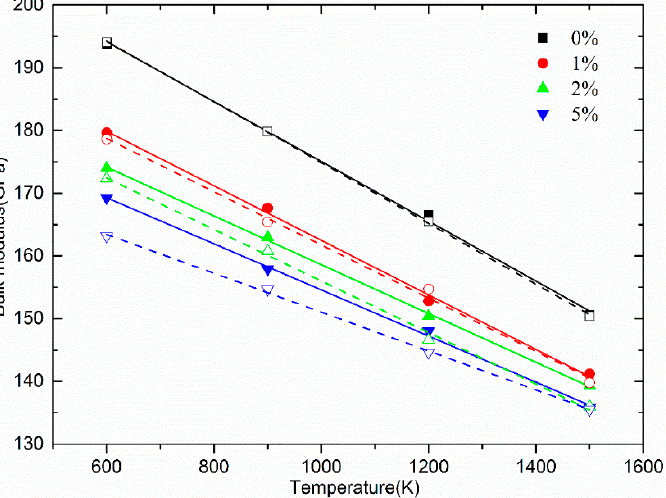
Figure 5. Variation of the bulk modulus of UO 2 containing different concentrations of Frenkel (dash) and antisite defects (solid) versus temperature. The fitted lines are also included in the figure.